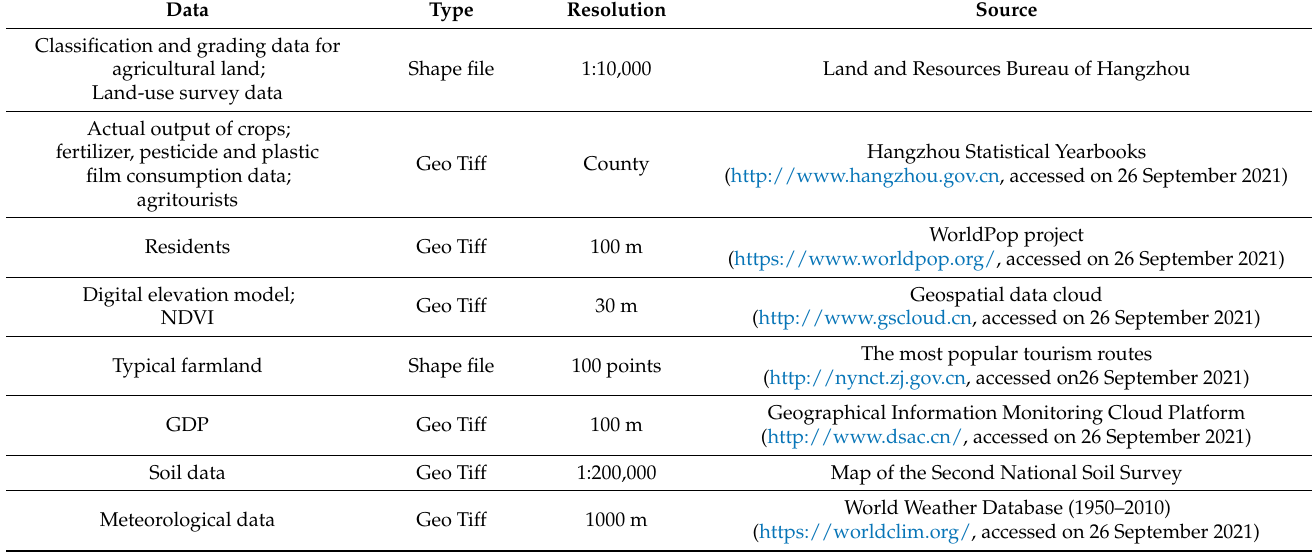
Table 1. Description of the datasets utilized in this study.